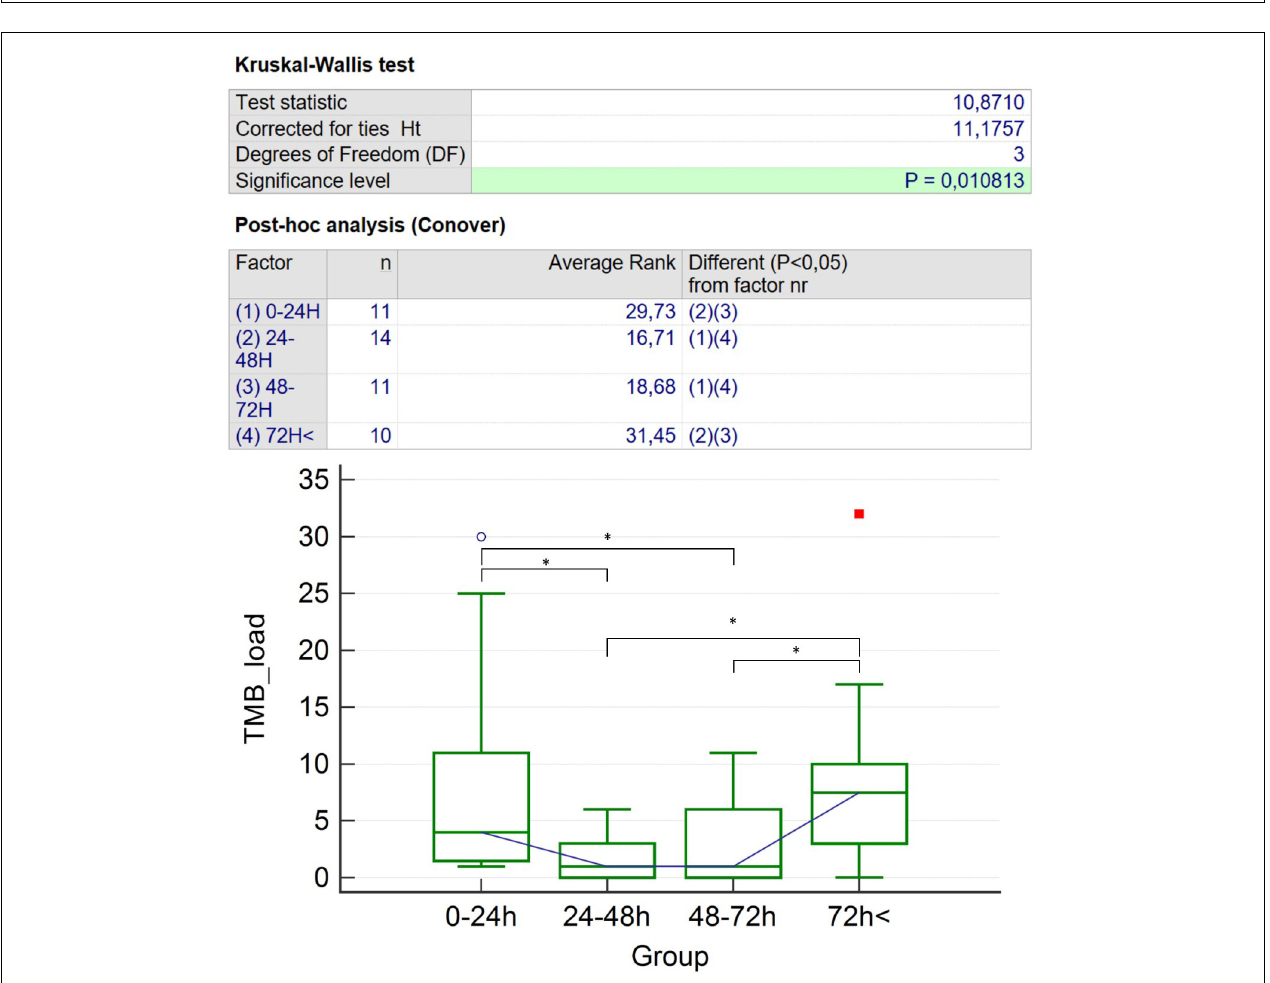
FIGURE 6 | Kruskal–Wallis with Conover post hoc test: results for TMB number differences. The symbol “*” represents significant ( p < 0.05) differences of TMB count; the blue circle and the red square stand for the two patients with the highest TMB count. TMB, traumatic microbleed. * represents significant ( p < 0.05) differences of TMB